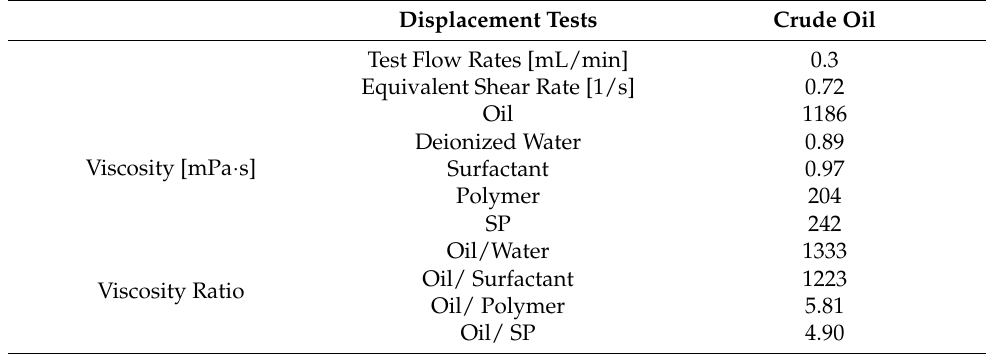
Table 2. Viscosity ratios for crude oil